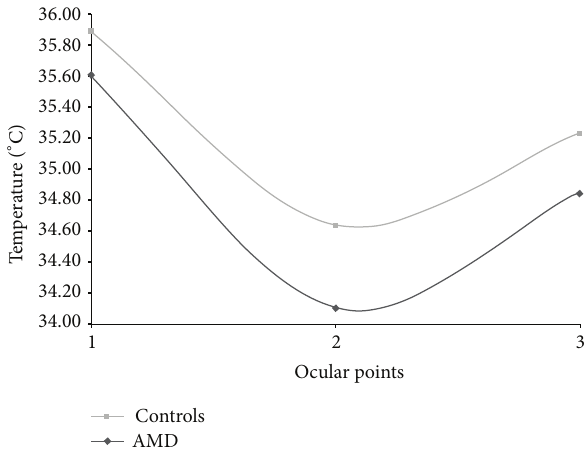
Figure 3: Comparison among the average OST profiles of all AMD groups.